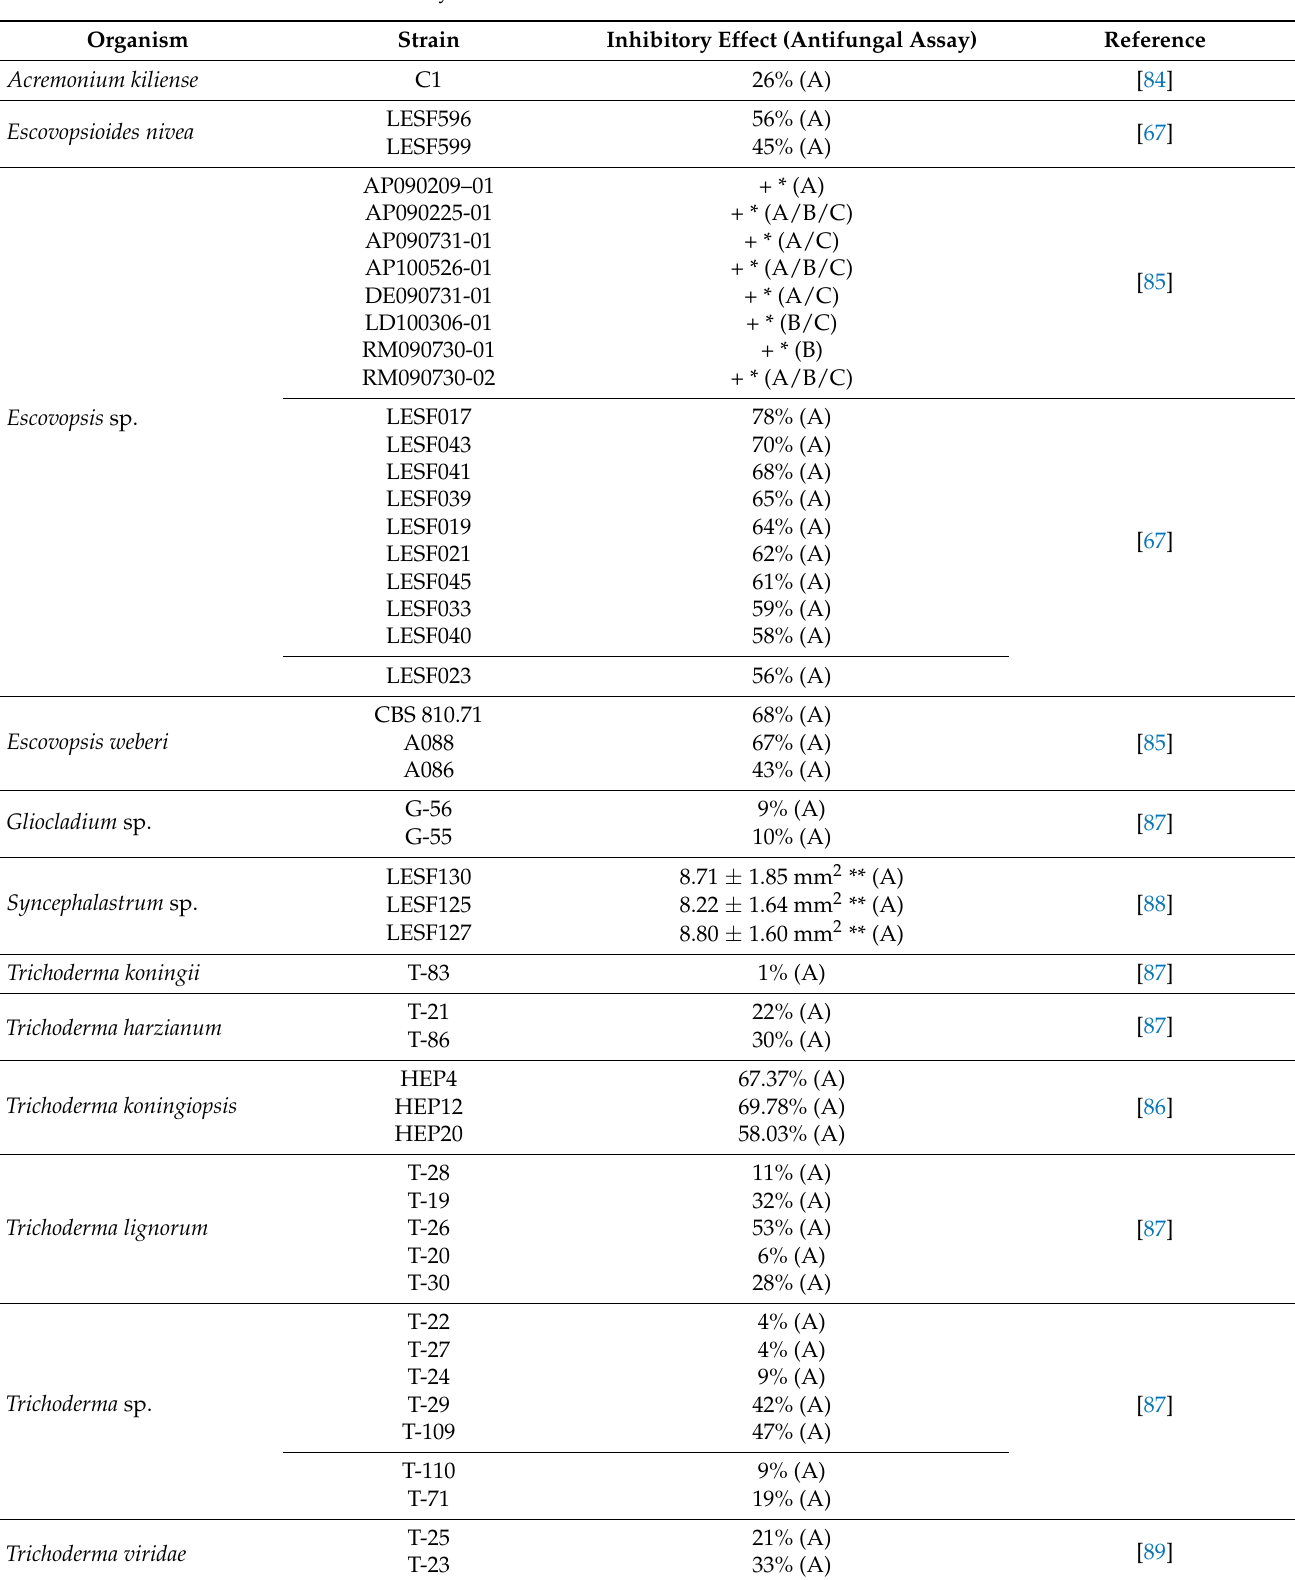
Table 5. Microorganisms with potential antifungal effects against Leucoagaricus gongylophorus by in vitro